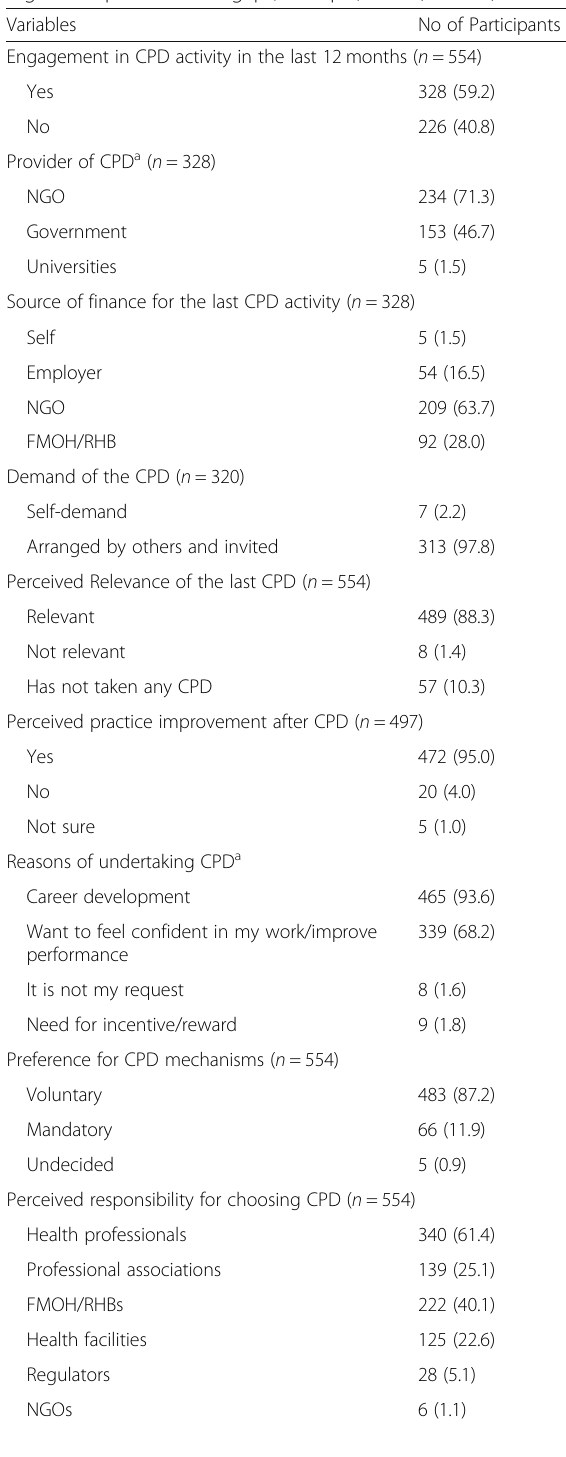
Table 5 Experiences regarding CPD, exploring health workforce regulation practices and gaps, Ethiopia, 2015 ( N = 554)